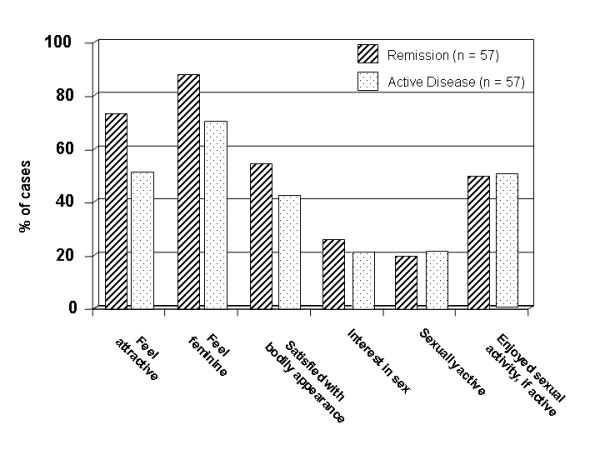
Results from EORTC-QLQ CR30 items, clinical sample only (n = 114). Proportions of those answering "very"/"moderate" (vs. "little"/"not at all").